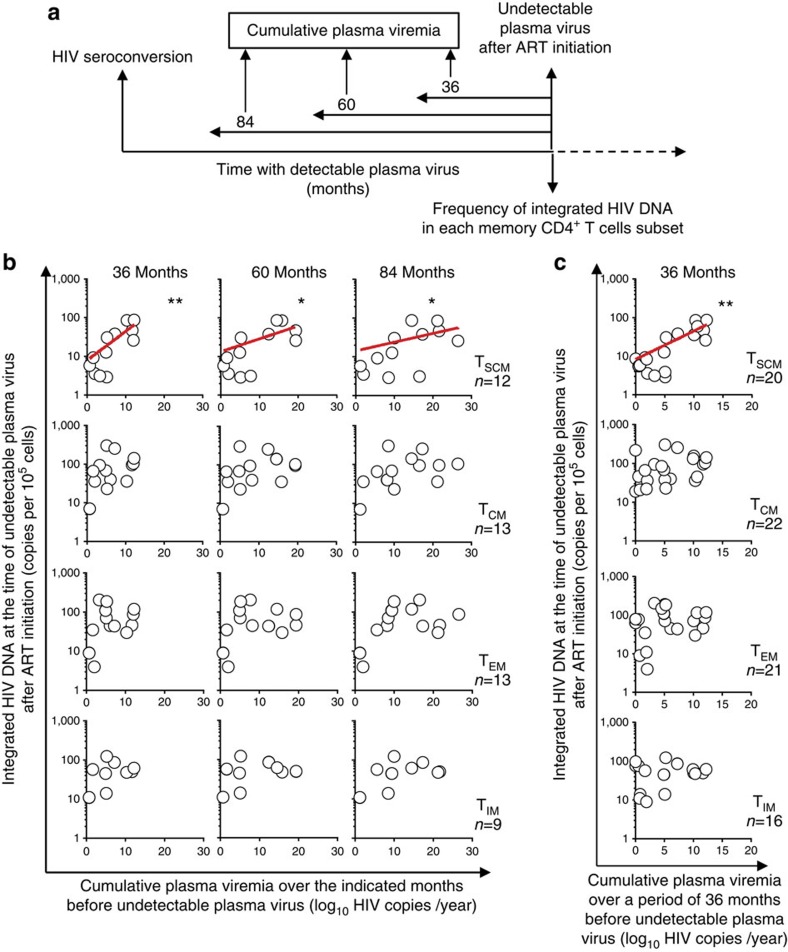
The frequency of latent infection of TSCM is related to cumulative plasma virus exposure.(a,b) Cumulative viremia, expressed as log10 virus copy-years during periods of 36, 60 and 84 months before plasma virus became undetectable, was determined in patients (n=9–13) for whom virological follow-up was available for a period of 84 months. Associations were sought between cumulative viremia and the frequency of latent infection of each memory subset at the time when plasma virus became undetectable after ART initiation. For each patient, the frequency of latent infection of each memory subset at the time when plasma virus became undetectable after ART initiation was calculated from the slopes of the decay curves shown in Fig. 2a. The number of patients for whom virological follow-up was available over a period longer than 84 months before undetectable plasma virus, was insufficient for statistical analysis. In c, the same analysis was performed for all patients (n=16–22) for whom virological follow-up was available over a period of 36 months before plasma virus became undetectable. The Spearman rank test was used for statistical analysis (*P<0.05, **P<0.01).